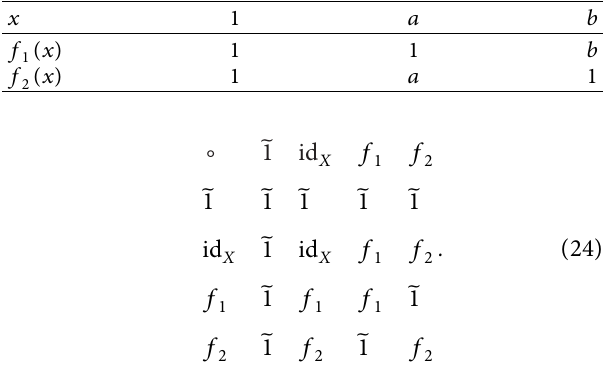
Table 1: Self-maps f